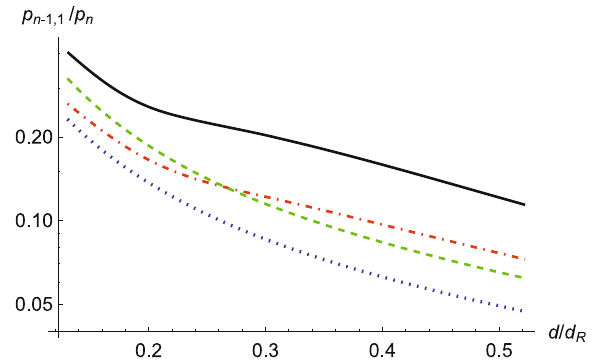
Fig. 5 Dependence of the overall detection probabilities ratio on the normalized slit size d / d R (see details in the text). The n th photon is detected in the region Ω ¼ f k : k max (cid:6) j k j (cid:6) 2 k max g (solid black and dashed green lines) or Ω ¼ f k : k max (cid:6) j k j (cid:6) 1 : 5 k max g (dot-dashed red and dotted blue lines) for n = 4. The objects are shown in Fig. 3a (for solid black and dot-dashed red lines) and Fig. 3c (for dashed green and dotted blue